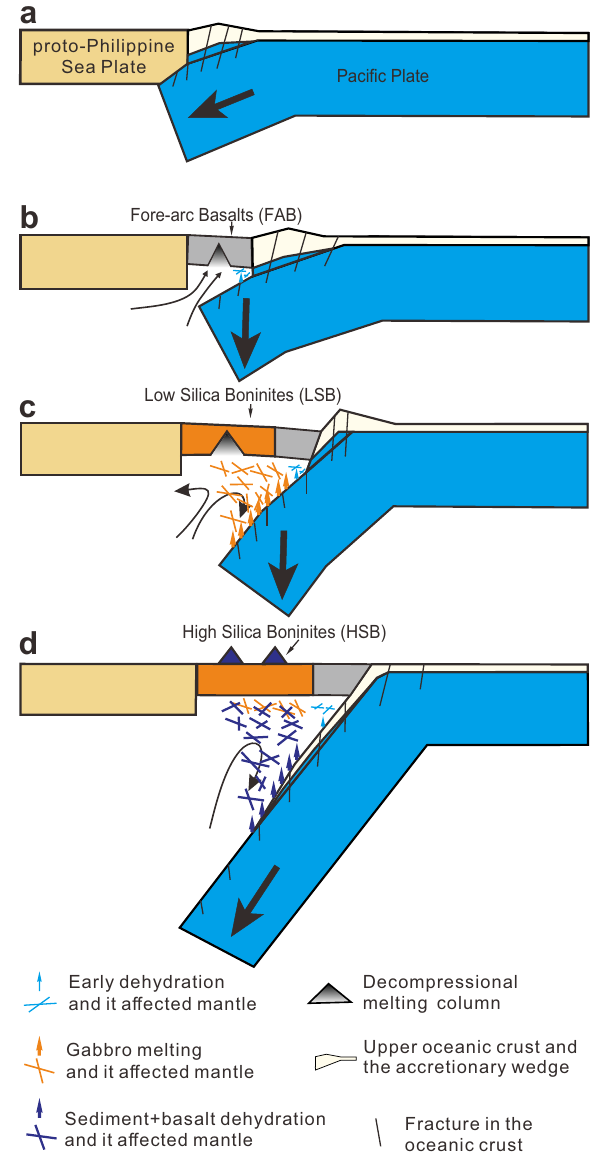
Fig. 7 Cartoons depicting subduction initiation and the slab dehydration/ melting processes. The model starts at a hypothetical transform fault at the boundary between the proto-Philippine Sea Plate and Paci fi c plate 69 . a Shallow angle convergence of the Paci fi c plate beneath the proto-Philippine Sea Plate resulted in accretion of Paci fi c sediments and upper crust. The lower crust experienced higher temperature metasomatism resulting in higher overall δ 11 B. b Decompression melting in response to slab rollback, producing forearc basalt (FAB). c low-silica boninite (LSB) genesis, depleted FAB mantle source metasomatized by lower crust melting components. d high-silica boninite (HSB) genesis, with an ultra-depleted mantle wedge after LSB extraction further metasomatized by hydrous fl uids from a mixed ocean crust source +